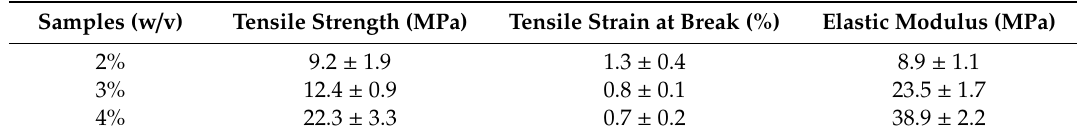
Table 2. Tensile results of the hemicellulose films